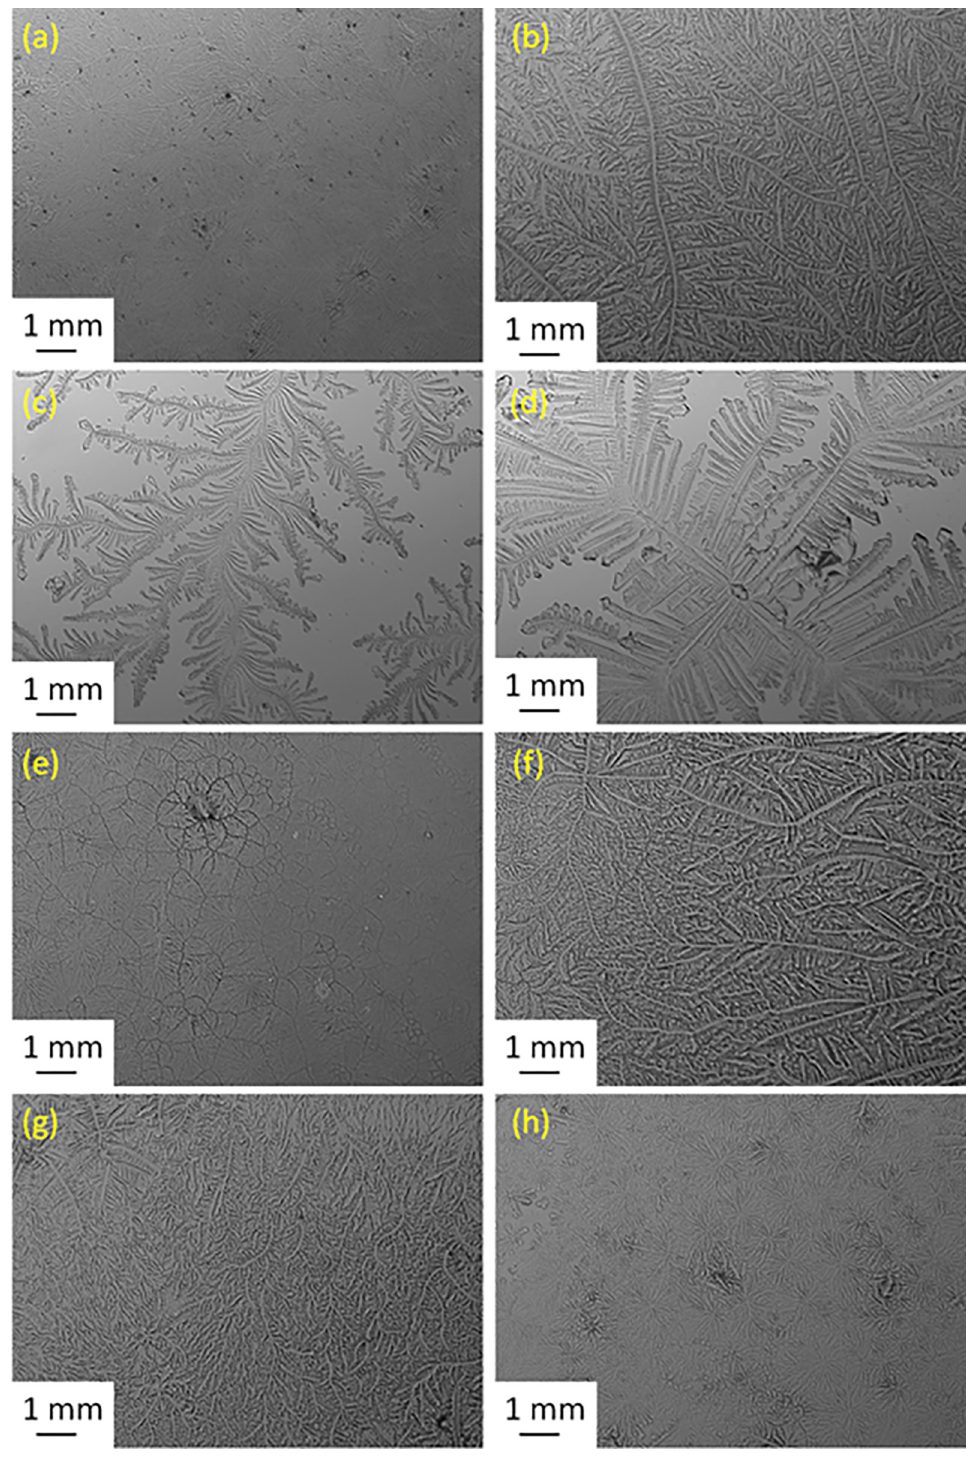
Fig 4. Representative TF images of the tears collected from four subjects with a high BMI before (a, c, e, and g) and after (b, d, f, and h) wearing a surgical face mask.